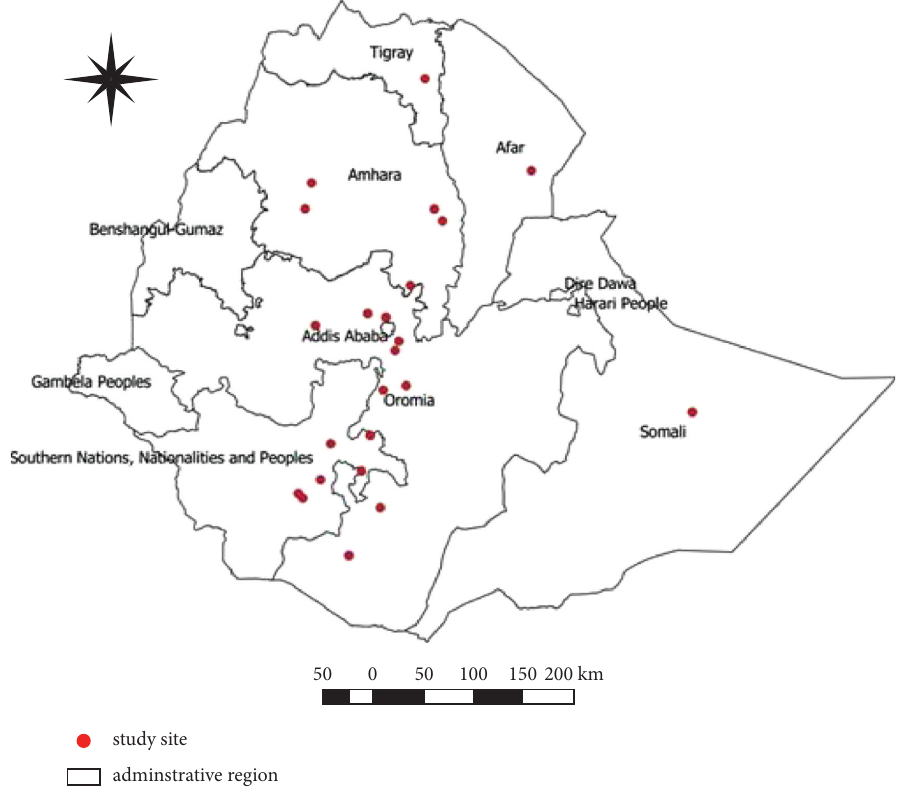
Figure 2: Observed spatial distribution of calf mortality in Table 2: Pooled prevalence estimates of calves’ mortality, stratified by subgroups.